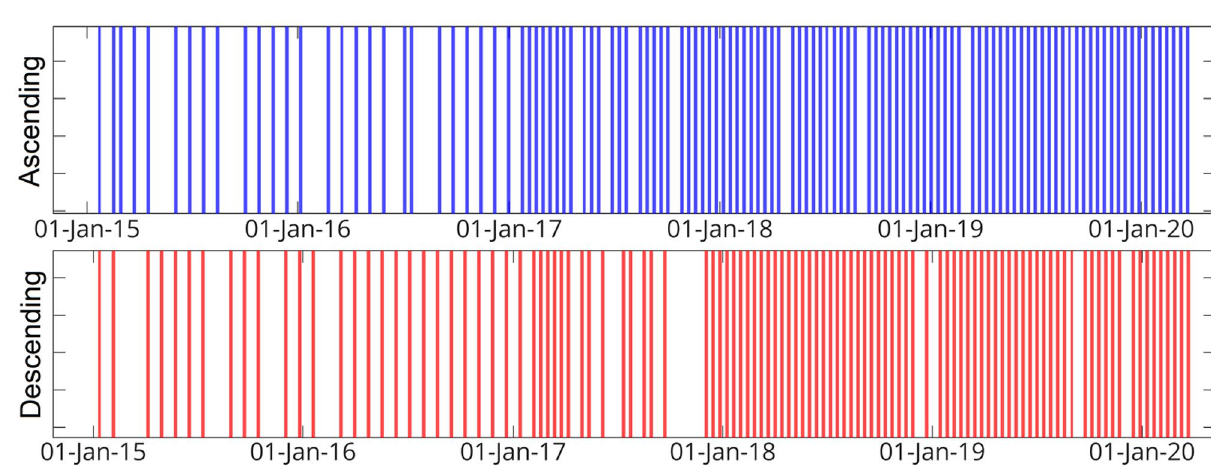
Figure 3. Temporal sampling of sentinel-1 images for InSAR analysis in the ( a ) ascending (blue), and ( b ) descending track